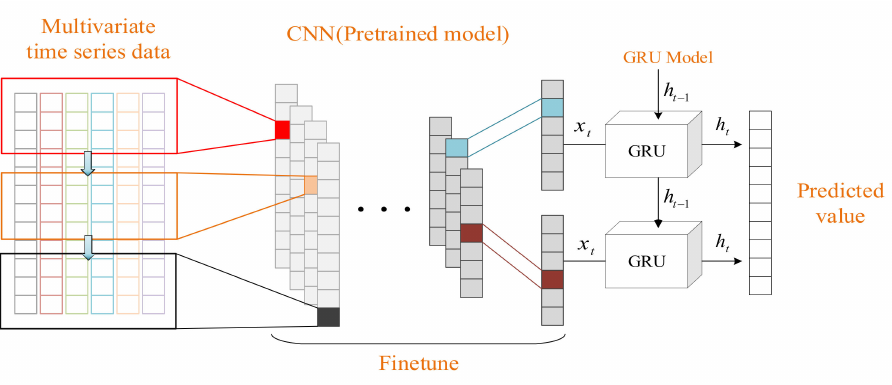
Figure 6. Hybrid Model of CNN—GRU Network.